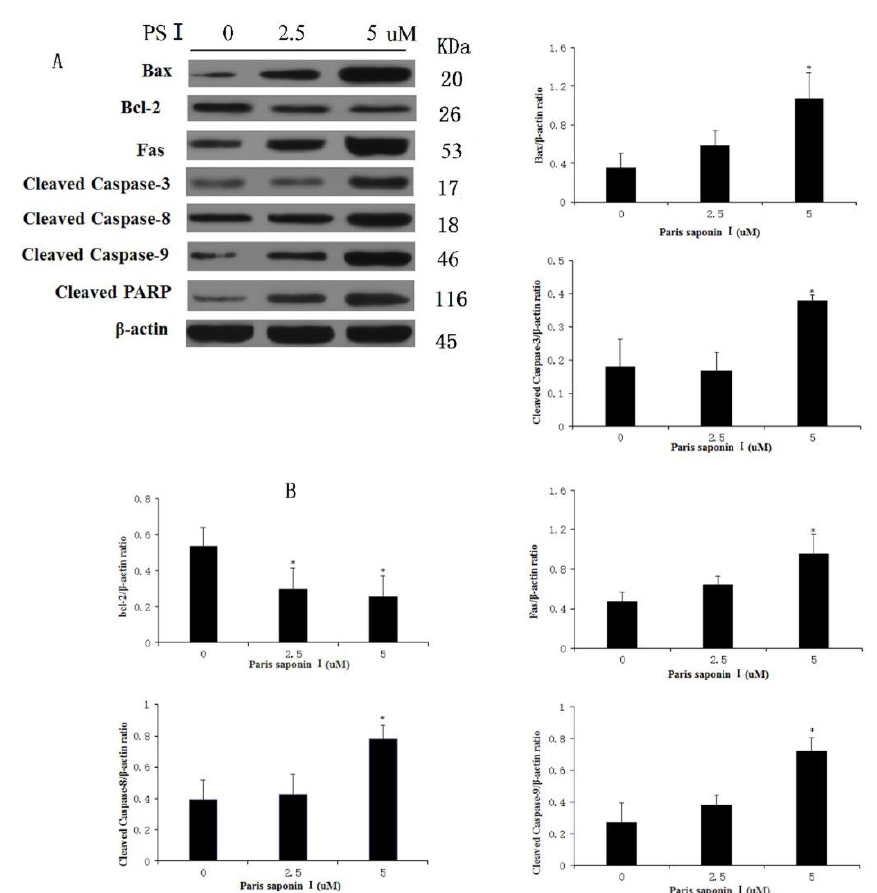
Figure 9. E ff ect of PSI on the expressions of apoptosis-related proteins in HepaRG cells. ( A ) Protein levels of Fas, Bax, Bcl-2, caspase-3, -8, -9 and PARP after treatment with PSI for 24 h, as determined with western blot analysis ( B ) Quantitative display of optical density values. Data are presented as mean ± SD of the three experiments. * p < 0.05, compared with the vehicle-treated group.